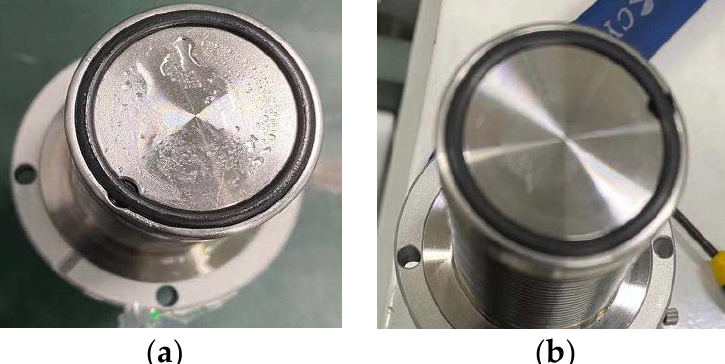
Figure 9. Comparison image ( a ) before and ( b ) after the improvement of the water vapor residue.